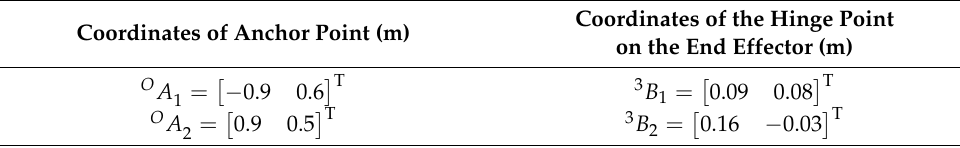
Table 2. 0 − 0 − 2 configuration of cable-driven planar hybrid robot.